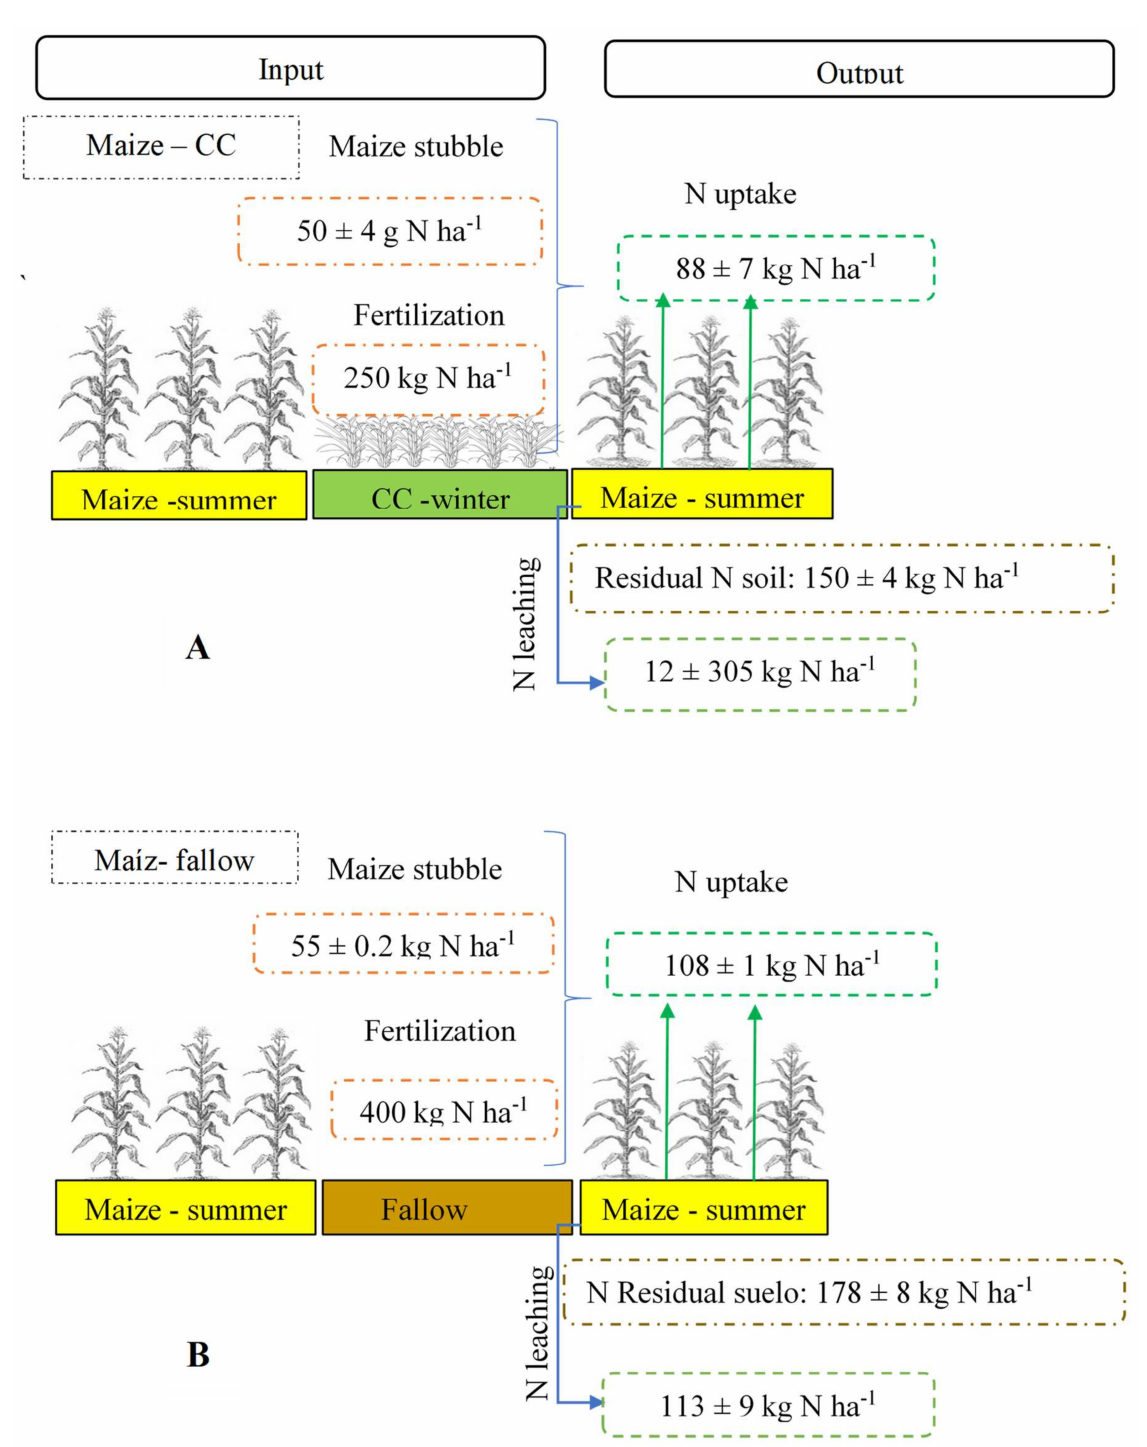
Figure 8. Nitrogen balance in the production system: ( A ) maize–cover crop rotation with optimal N fertilization dose; ( B ) maize–fallow rotation with excessive fertilization N dose, derived from the present